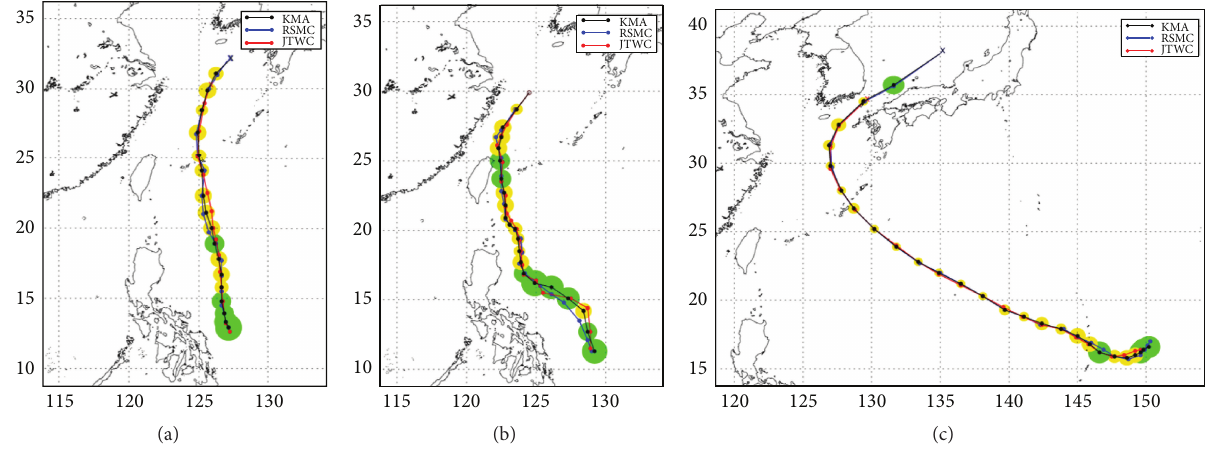
Figure 12: Best tracks for (a) Typhoon LEEPI (1304), (b) KONG-REY (1315), and (c) DANAS (1324) from RSMC, JTWC, and KMA. Shading denotes the optimal PI of KMA. Yellow and green imply less than 55 km and 55–110km as the radius of PI.